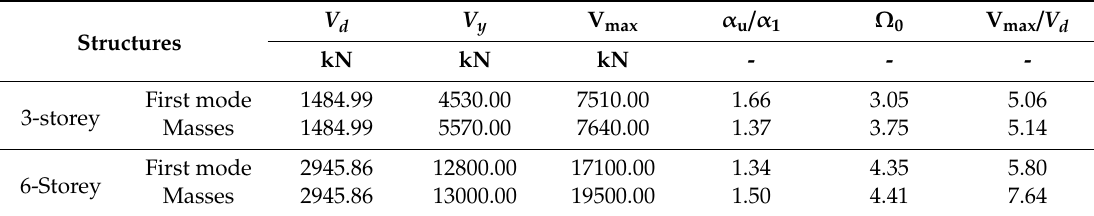
Figure 7. Pushover curves for examined concentrically braced frames (CBFs). Table 7. Results from puhsover analyses performed on examined